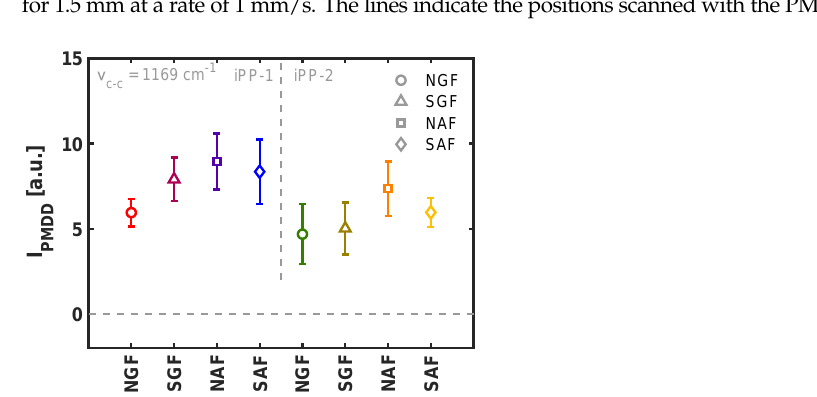
Figure 8. Cross-polarized micrographs of the various fibers embedded in an iPP-1 matrix after shearing for 1.5 mm at a rate of 1 mm/s. The lines indicate the positions scanned with the PM-SIRMS technique.